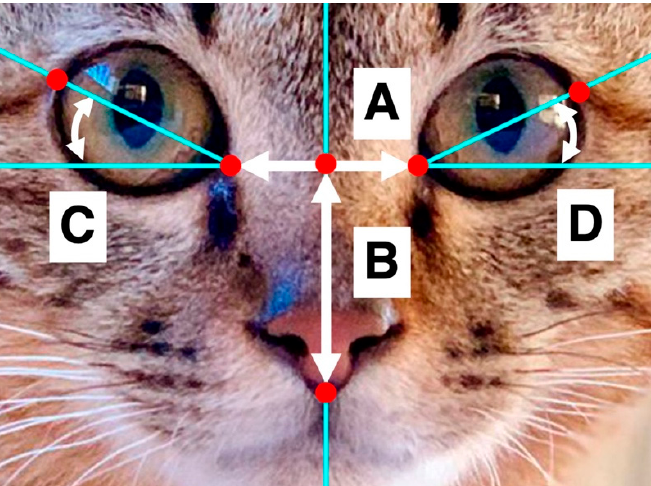
Figure 2. Measurement of facial morphology: A—distance between the right eye and left eye; B—length from the center line of the eye to the bottom of the nose; C—angle of the right eye; D—angle of the left eye.